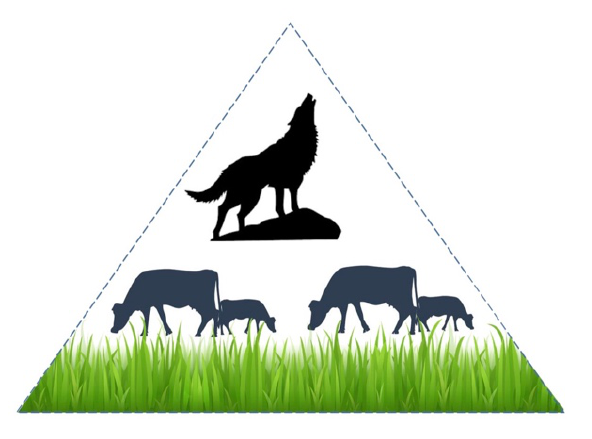
Fig. 1 . Representation of a food pyramid.